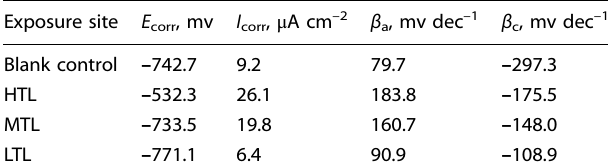
Table 2. Fitted results of the potentiodynamic polarisation curves for the AISI 4135 steel samples after exposure to the tidal zone for 3 months.